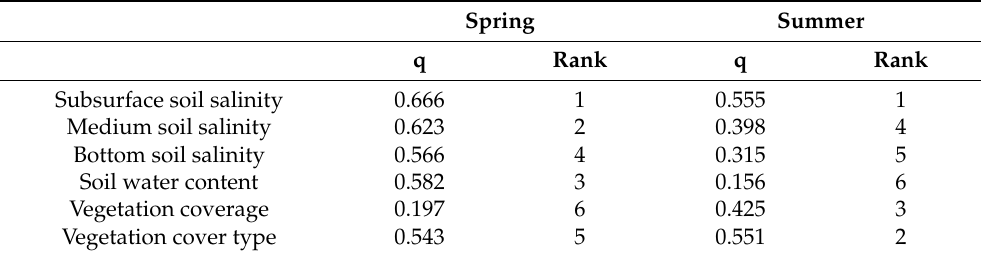
Table 7. Explanatory power of salinization driving factors in different seasons.